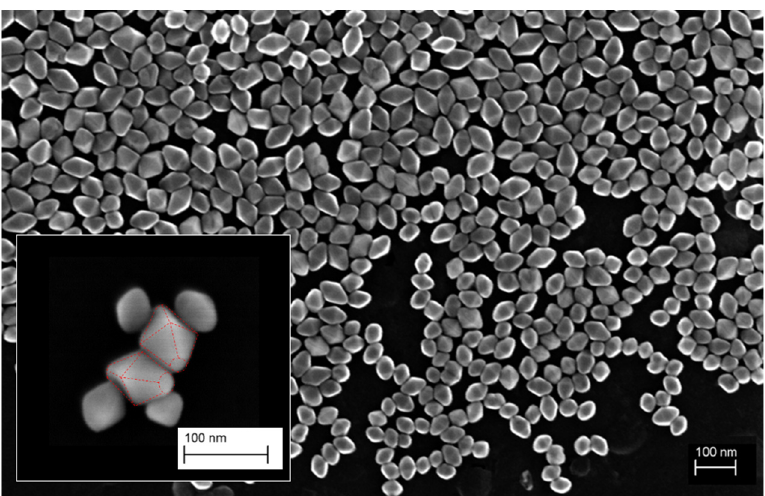
Figure 3. Twenty kilovolt InLens SEM images of TiO 2 NPs deposited on a carbon TEM grid. Insert: Representation of bipyramid geometry on particles imaged by 3 kV InLens SEM on a silicon substrate.